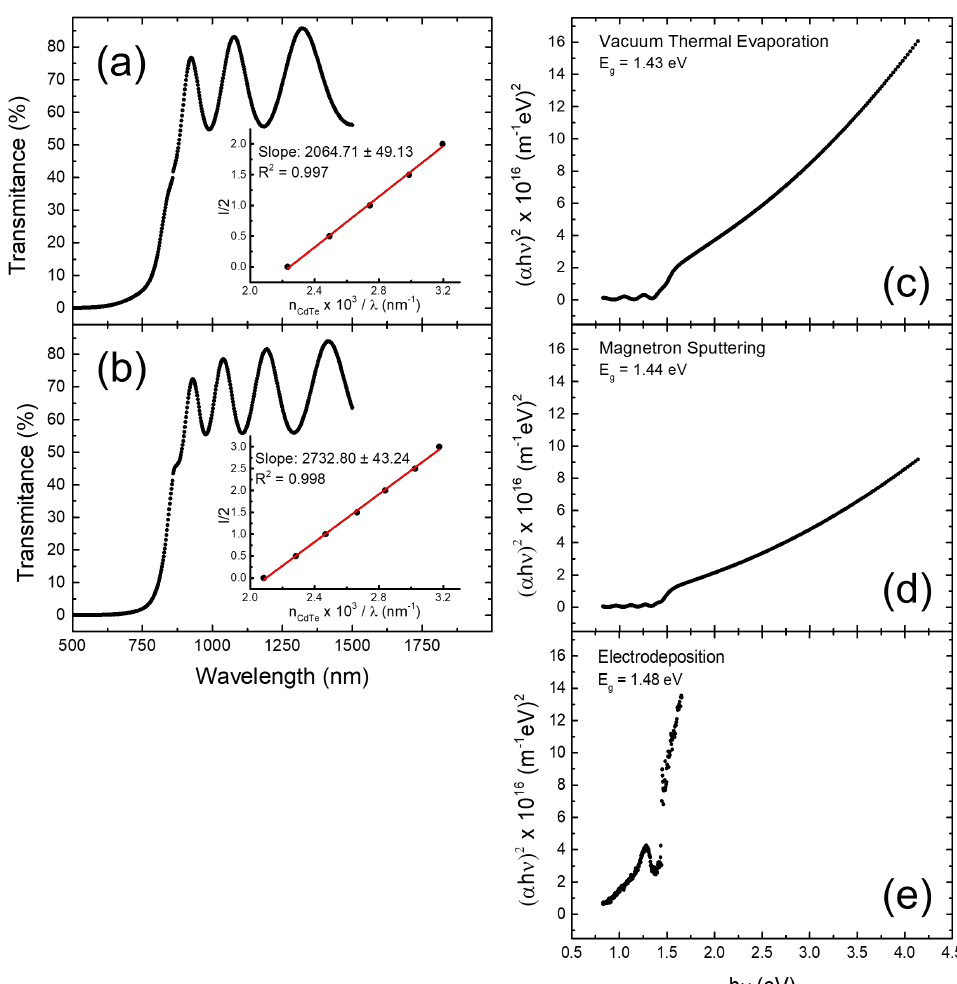
Figure 7. ( a , b ) The transmission spectra of the CdTe films deposited by VTE ( a ) and RF-MS ( b ). The insets represent linear fitting plots used for thickness evaluation. The obtained slope values and associated standard errors (SEs) are indicated. R 2 represents the coefficient of determination. ( c – e ) The absorption spectra obtained for CdTe films fabricated by VTE ( c ), RF-MS ( d ), and ECD ( e ). The